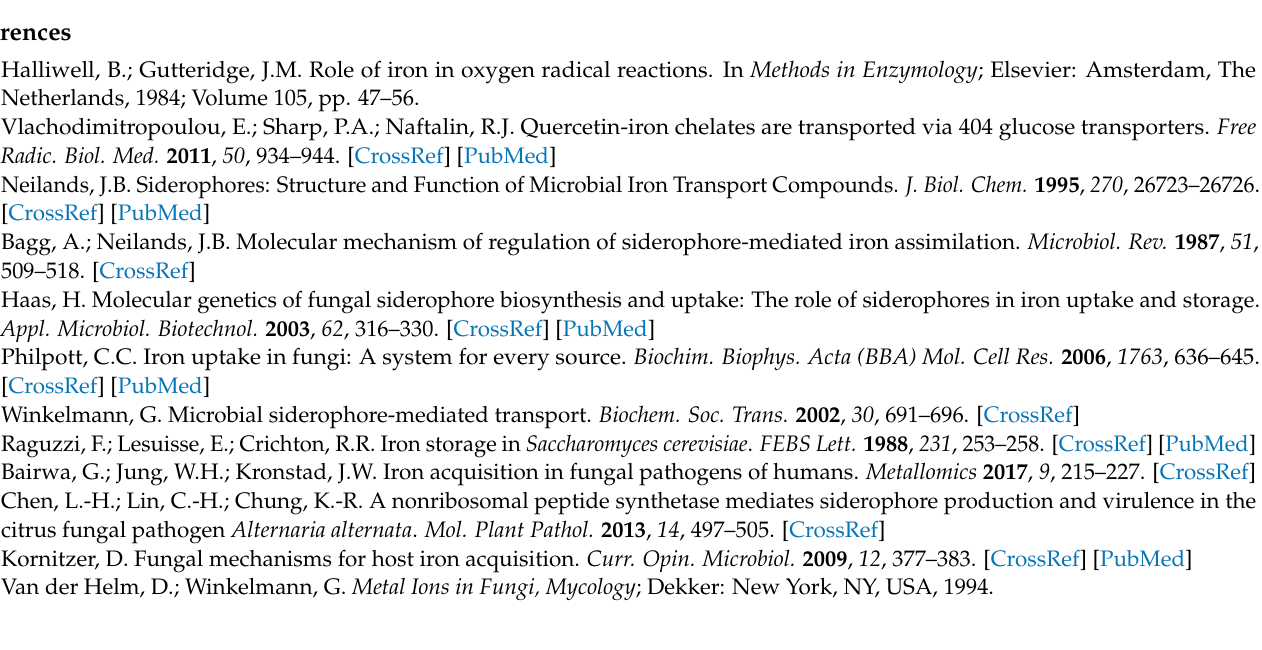
Figure S5: Deletion of the AaHapE gene using a split marker approach in the tangerine pathotype of A. alternata ; Figure S6: Pairwise comparison and alignment of conserved motifs of the AaAtf1 sequence with fungal Atf1 orthologs; Figure S7: Pairwise comparison and alignment of conserved motifs of the AaHapX sequence with fungal HapX orthologs; Figure S8: Pairwise comparison and alignment of conserved motifs of the AaHapB sequence with fungal HapB orthologs; Figure S9: Pairwise comparison and alignment of conserved motifs of the AaHapC sequence with fungal HapC orthologs; Figure S10: Pairwise comparison and alignment of conserved motifs of the AaHapE sequence with fungal HapE orthologs; Figure S11: HPLC analyses of siderophores isolated from the strains of A. alternata ; Figure S12: qRT-PCR analyses; Figure S13: Sensitivity tests; Table S1: Oligonucleotide